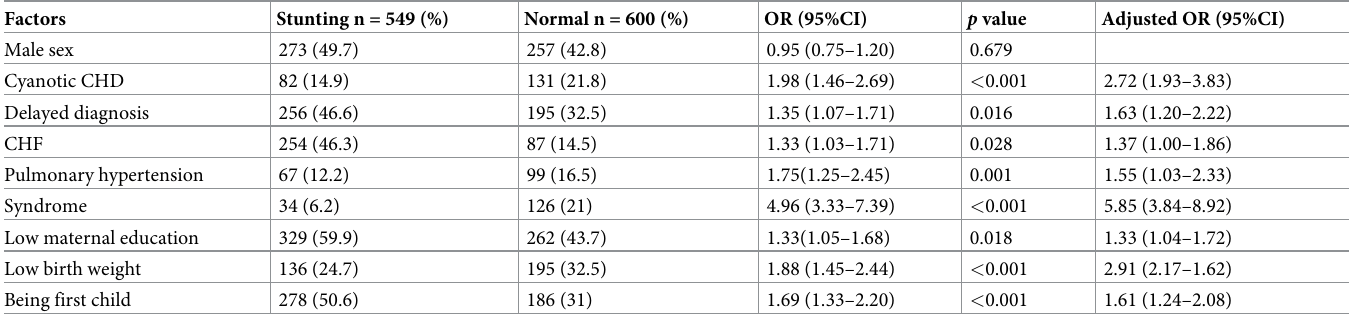
Table 3. Factors associated with